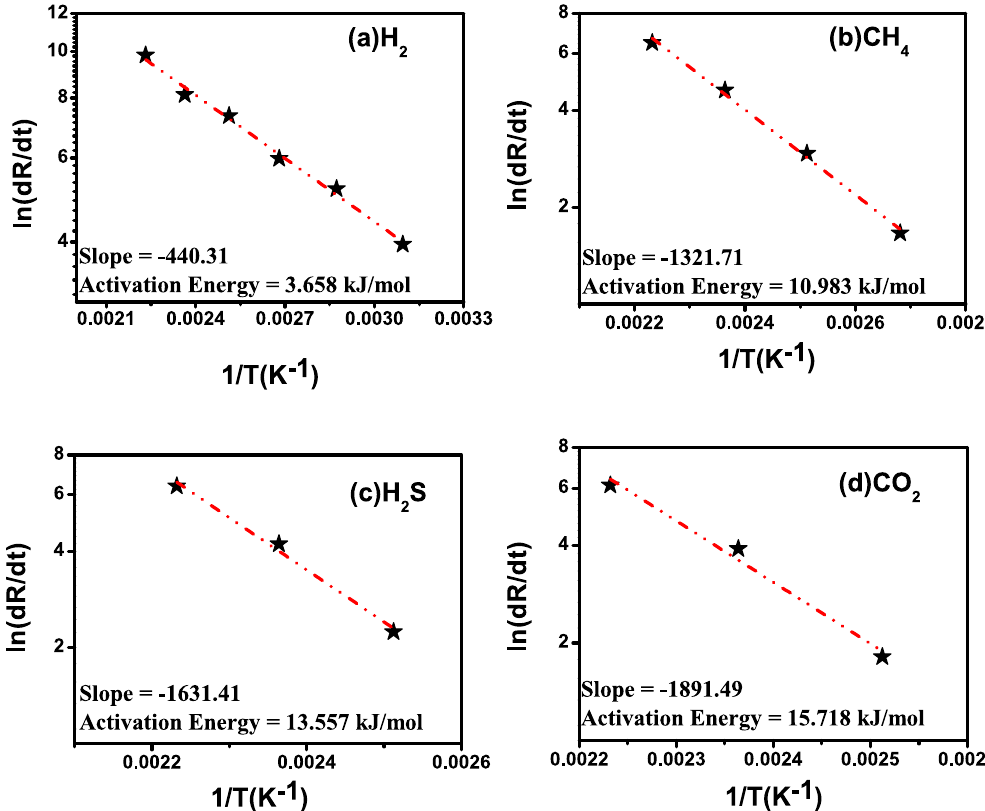
Figure 6. Arrhenius plot of rate of resistance change with temperature after exposure of 1% concentration of ( a ) H